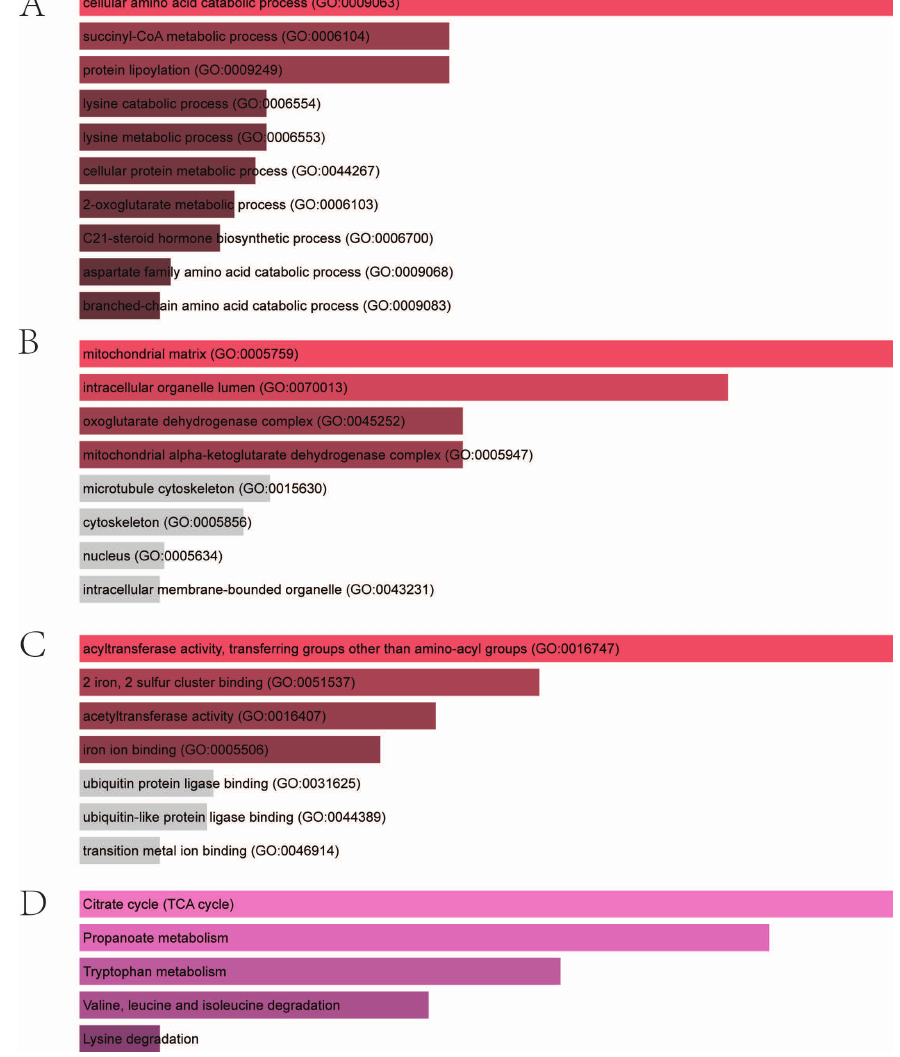
Figure 4. Enrichment analysis of four hub genes. ( A ) Significantly enriched biological